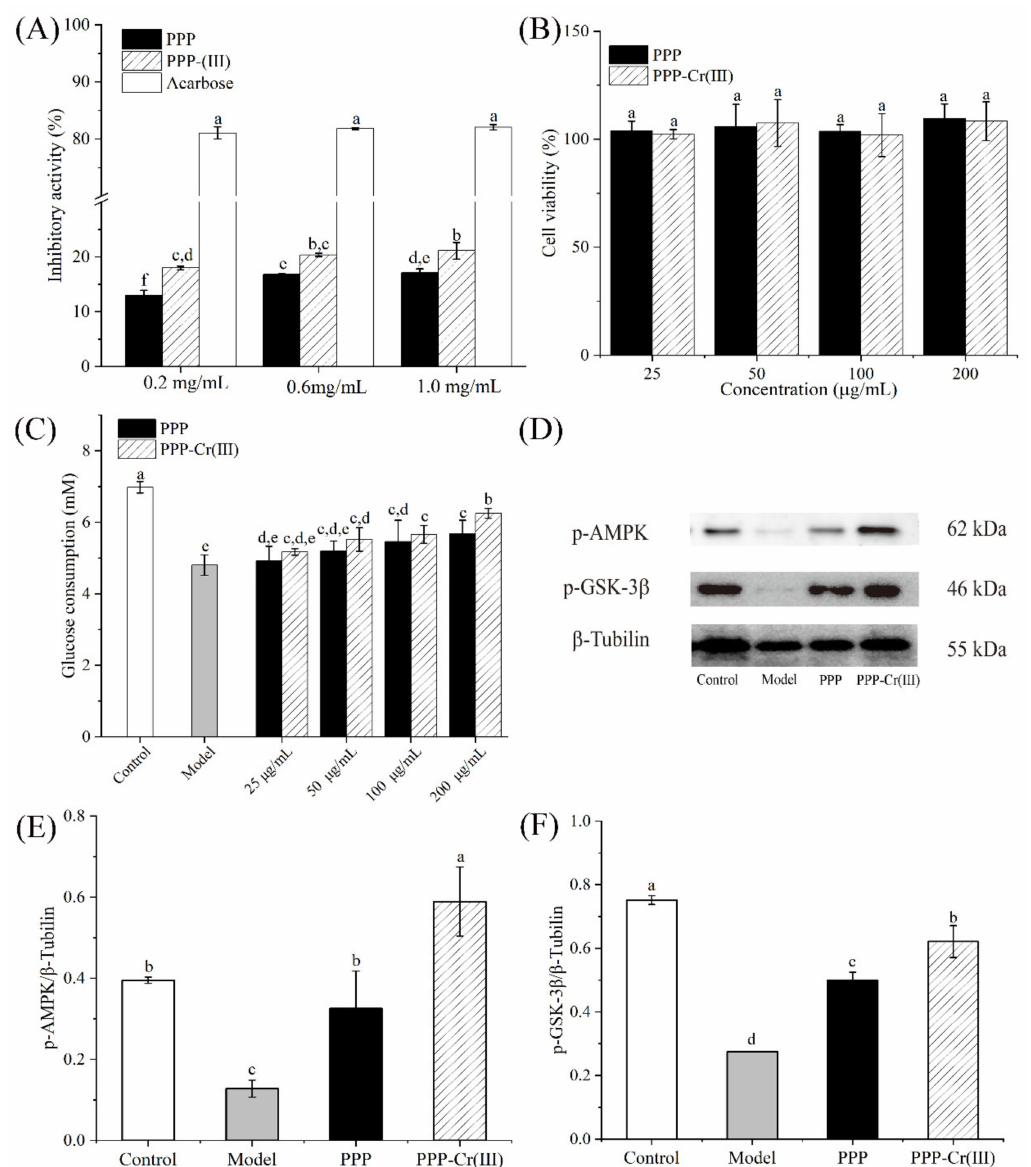
Figure 4. Hypoglycemic activities of PPP and PPP-Cr(III). Inhibition activity on α -glucosidase ( A ); effect on the cell viability ( B ); glucose consumption ( C ); Western blot bands of p-AMPK and p-GSK- 3 β ( D ); protein expression level of p-AMPK/ β -Tubilin ( E ), and p-GSK-3 β / β -Tubilin ( F ). The different letters above the adjacent bars indicate significant differences ( p < 0.05, n = 3), while the same letter indicates no significant